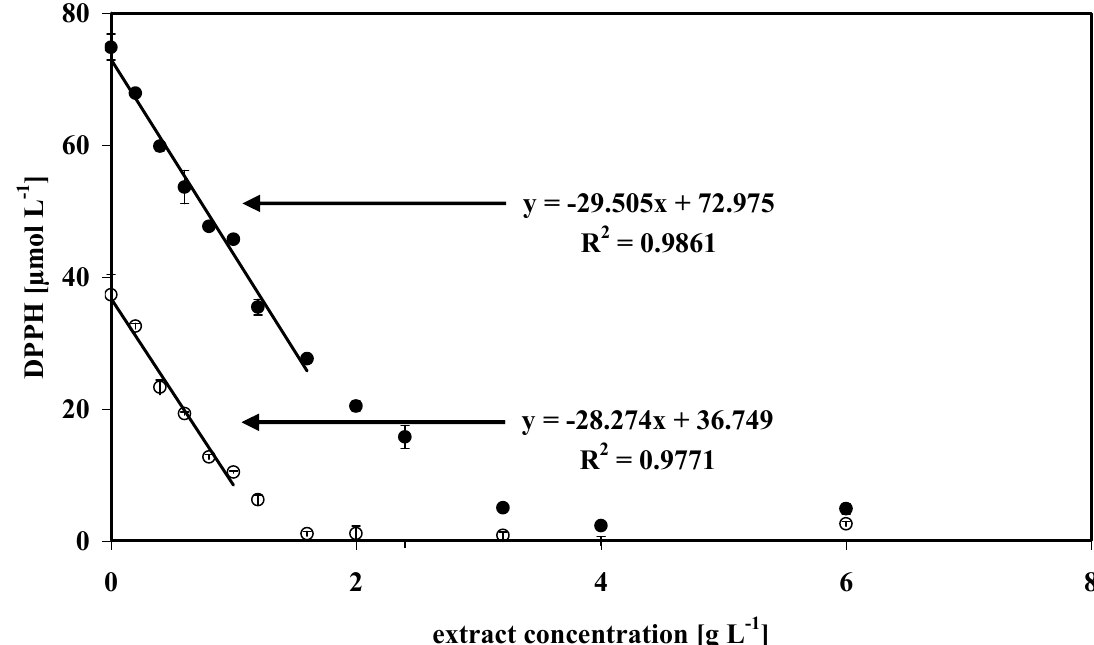
Figure 4. Absorbance decrease of the DPPH radical measured at 550 nm for Isochrysis galbana . The reference cuvette is filled with the same extract concentration as the measuring cuvette. Open circles represent the data for using the low DPPH concentration (38 µmol L -1 ). Closed circles represent the data for using the high DPPH concentration (76 µmol L -1 ). The negative algebraic signs represent the reducing of the DPPH radical by the microalgae extract. Linear regressions calculated according to Equation